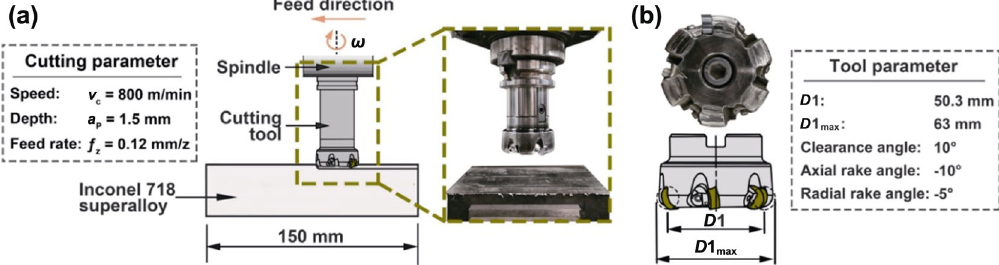
Fig. 2 (a) Schematic diagram of the machining test and (b) tool parameters. The effective diameter ( D 1) is 50.3 mm. The maximum diameter ( D 1 max ) is 63 mm. The clearance angle, axial rake angle, and radial rake angle are 10°, − 10°, and − 5°,